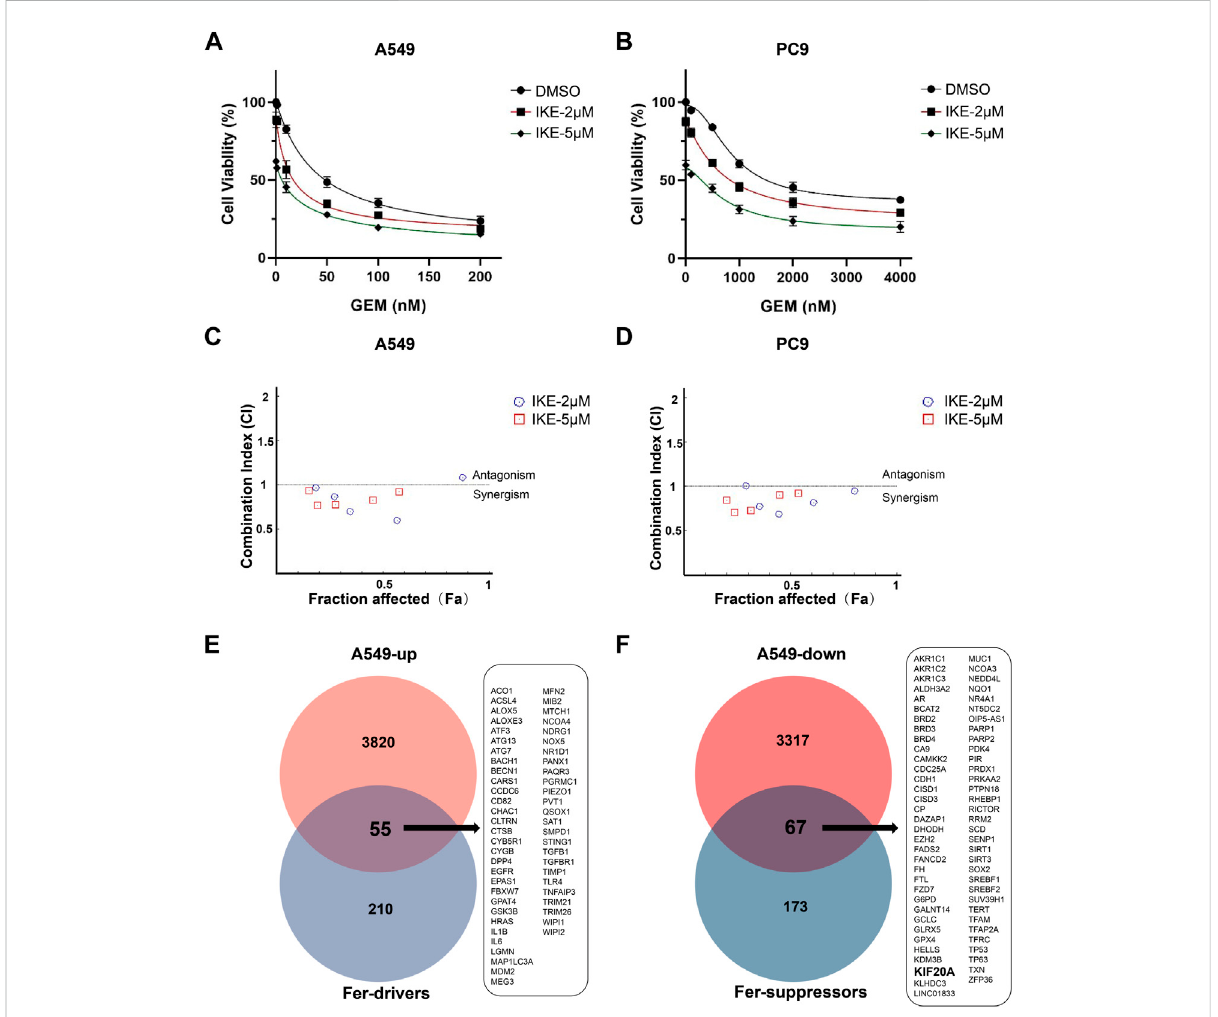
FIGURE 6 Combined treatment of GEM and IKE synergistically inhibited the proliferation of A549 and PC9. (A) A549 cell viability was assessed by CCK8 assay after treatmentwith different concentrations of GEM alone (0, 10, 50, 100 or 200 nM) or in combinationwith IKE (2 or 5 μ M) for 48 h (B) PC9 cell viability was assessed by CCK8 assay after treatment with different concentrations of GEM alone (0, 100, 500, 1000 or 2000 nM) or in combination with IKE (2 or 5 μ M) for 48 h (C,D) The software calculated and evaluated the combination index (CI) of GEM and IKE in A549 and PC9.CI=1,additive;CI > 1,antagonism;CI < 1,synergism. (E) VenndiagramshowingferroptosisdrivergenesupregulatedbyGEMtreatmentinA549. (F) Venn diagram showing ferroptosis suppressors downregulated by GEM treatment in A549. n = 3. GEM: Gemcitabine; IKE: Imidazole